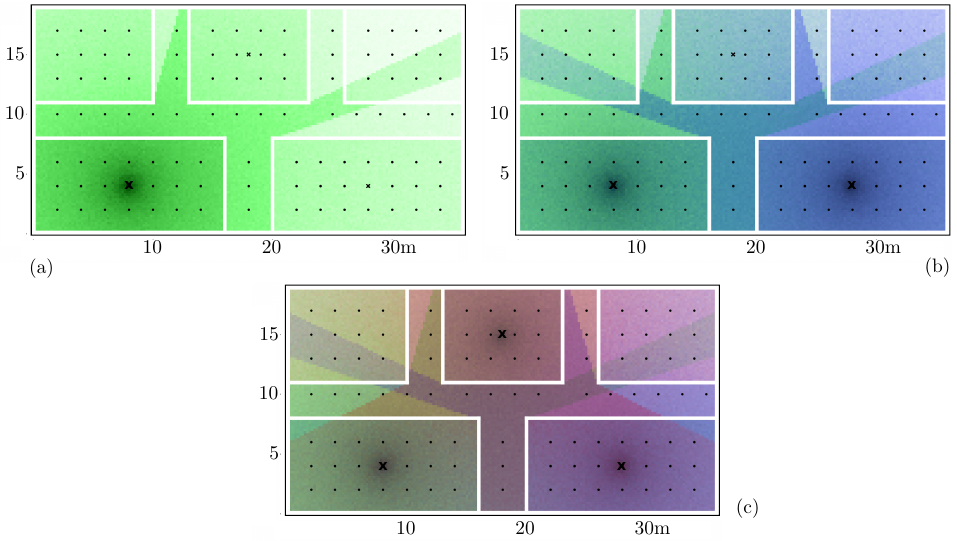
Figure 4. Example of a signal strength simulation: white lines are the walls of the rooms. X marks the position of the routers. In (a), we have only a single router in the most bottom-left room. While in (b) and (c) we have two and three routers, respectively. ( b , c ) we have two and three routers,